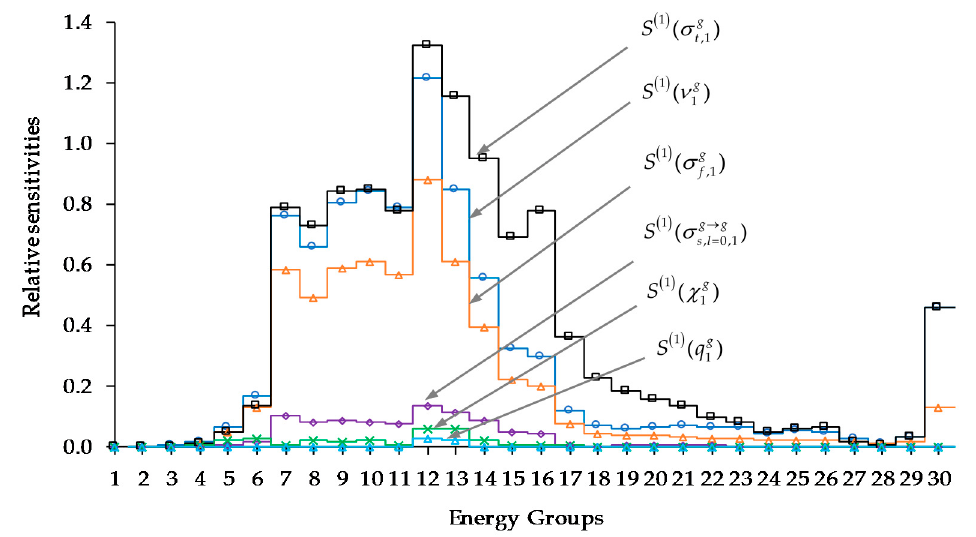
Figure 2. Comparison of first-order relative sensitivities for isotope 1 ( 239 Pu).